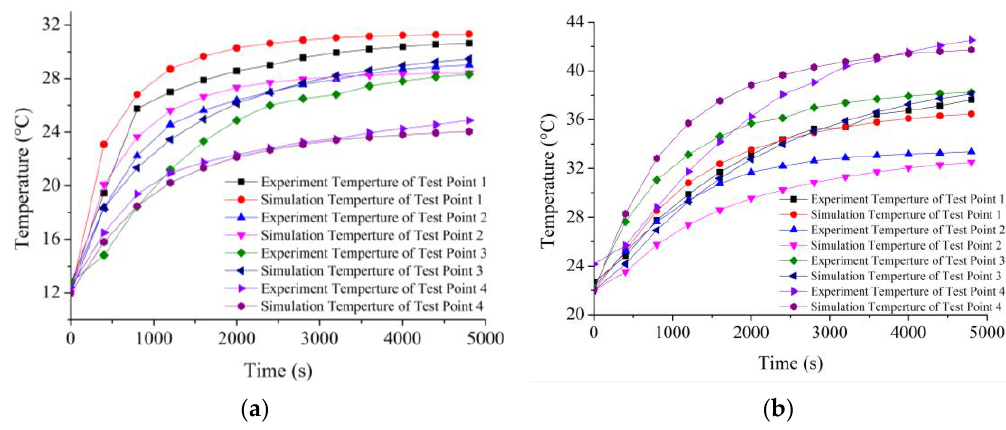
Figure 10. Comparison between the simulation temperature and experimental measurements. ( a ) Spindle speed of 10,000 rpm, ( b ) Spindle speed of 15,000 rpm.